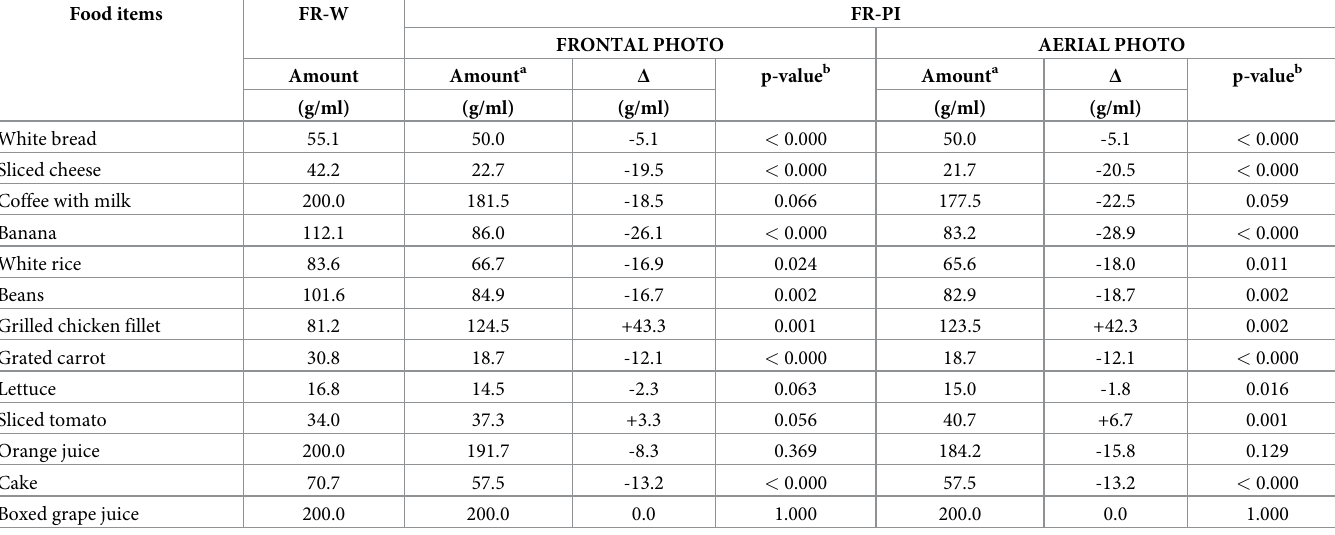
Table 2. Amount of food present in the meal, according to the weighed food record (FR-W) and the estimated food record based on photographic images (FR-PI) captured by the visually impaired participants. Natal, Rio Grande do Norte, Brazil